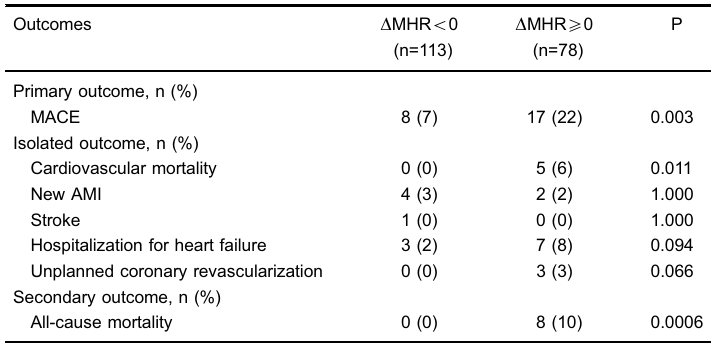
Table 2. Number of registered outcomes in D MHR o 0 and D MHR X 0 groups. Outcomes